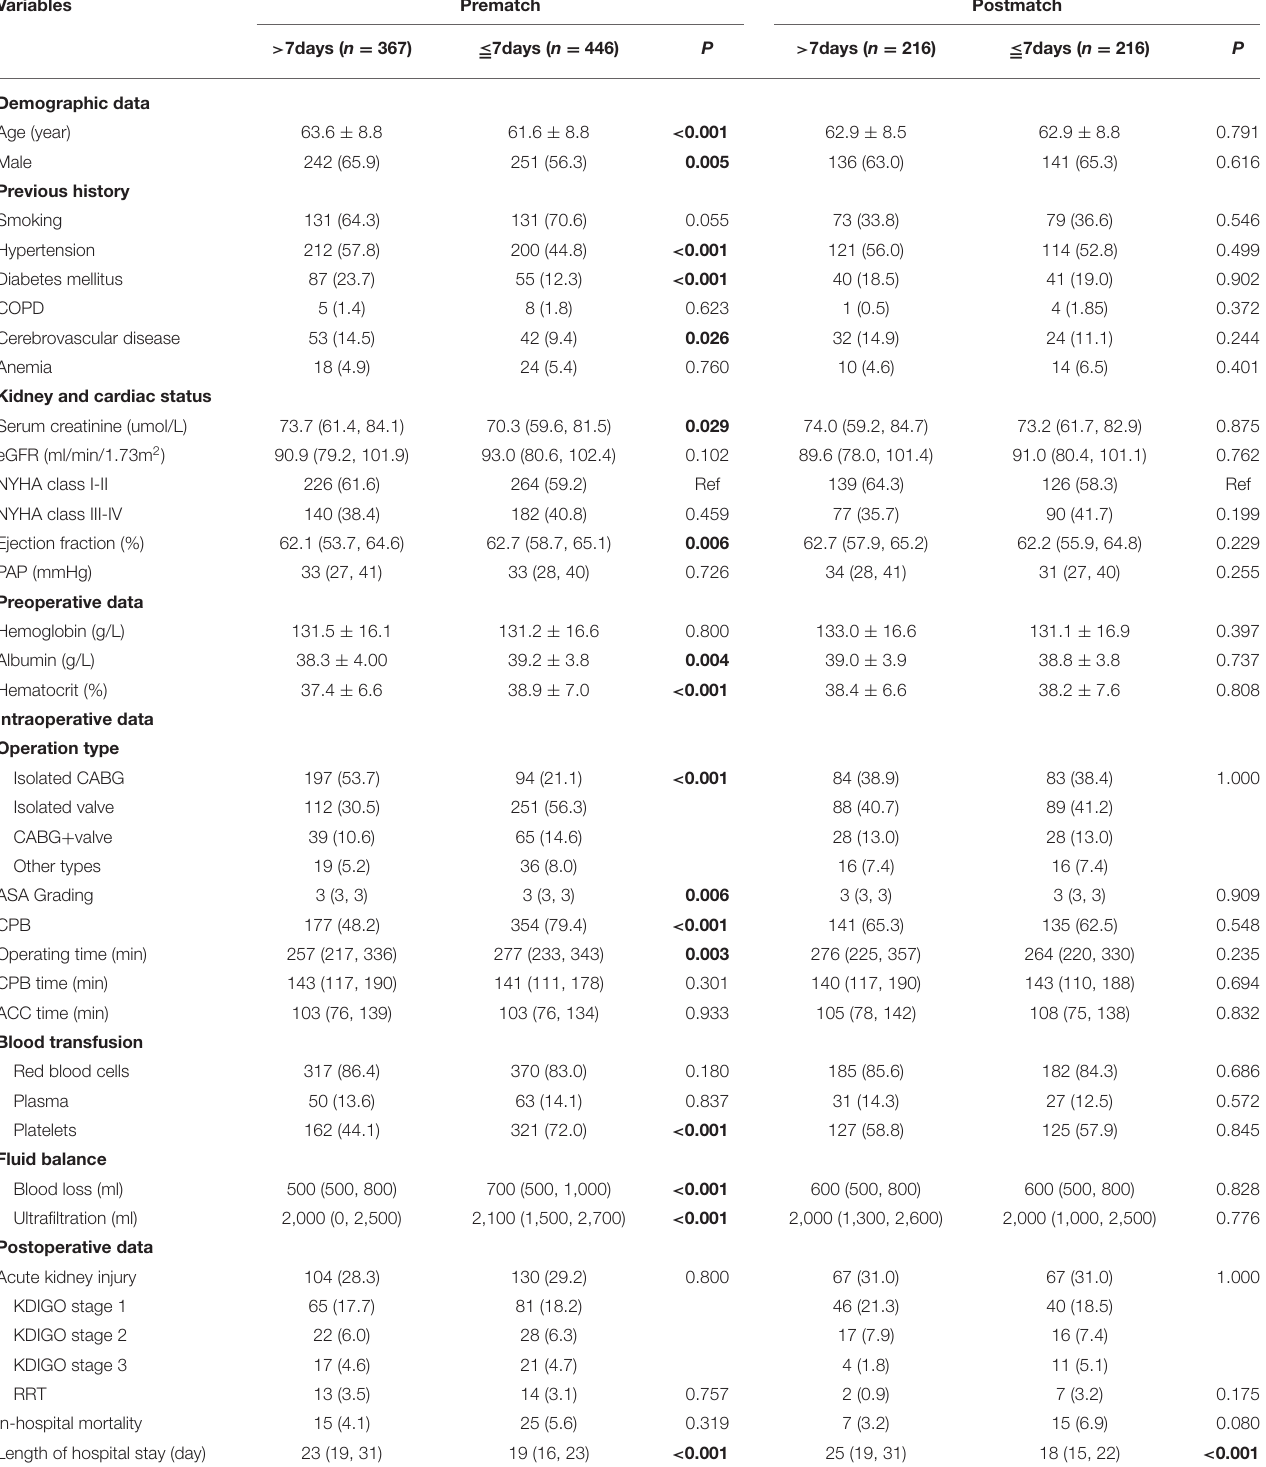
TABLE 1 | Baseline and perioperative characteristics of the patients stratified by the CAG interval. Variables Prematch